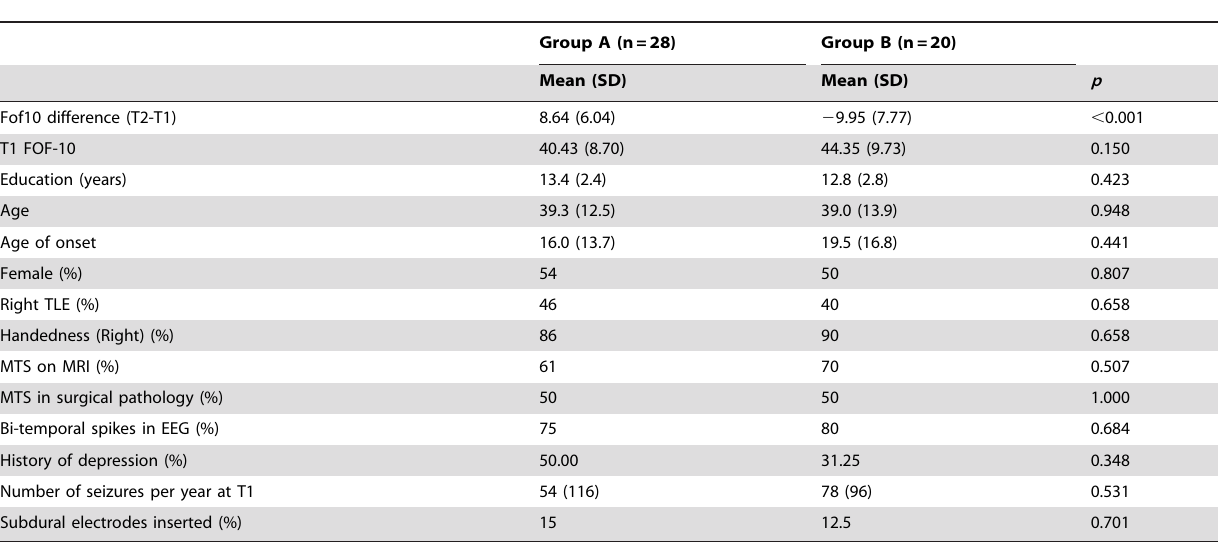
Table 1. Those with stable or improved SM (Group A) versus those with worsened SM (Group B) 1 year after surgery, in terms of seizure related factors, MAC-S and general SM